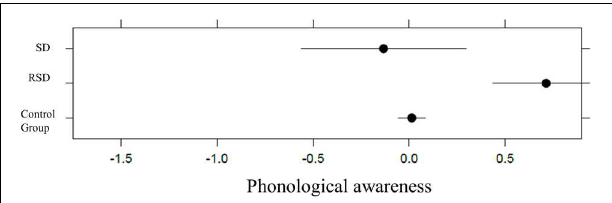
FIGURE 2 | Plot representation of SD, RSD, and control group in phonological awareness in kindergarten.